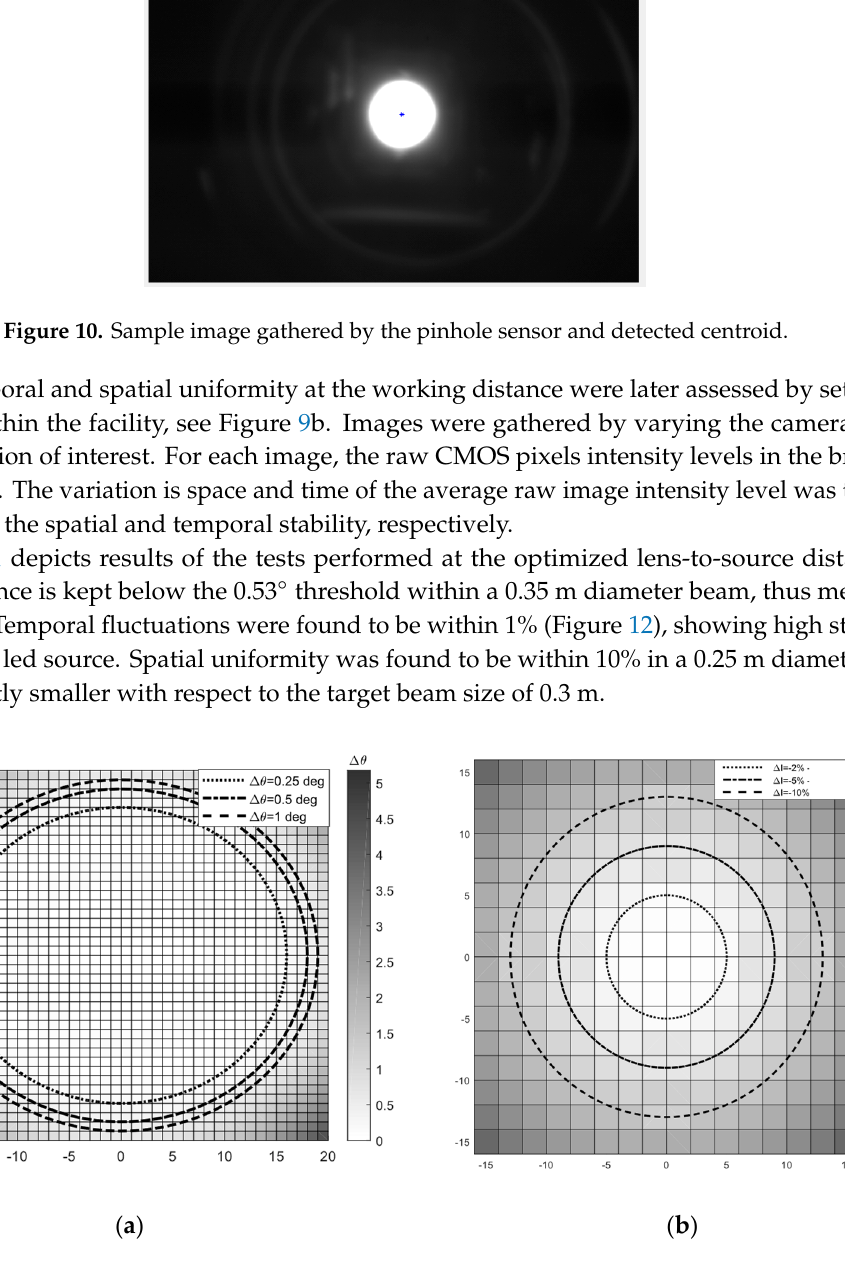
Figure 9. Sun Simulator. ( a ) Detailed view of Sun simulator with collimation device; ( b ) test setup for temporal stability and spatial uniformity measurements using a pinhole camera.